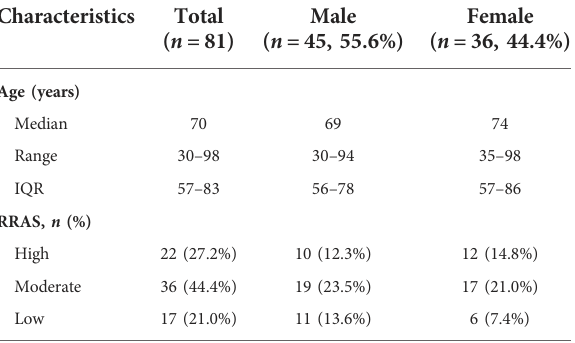
TABLE 1 Characteristics of survey